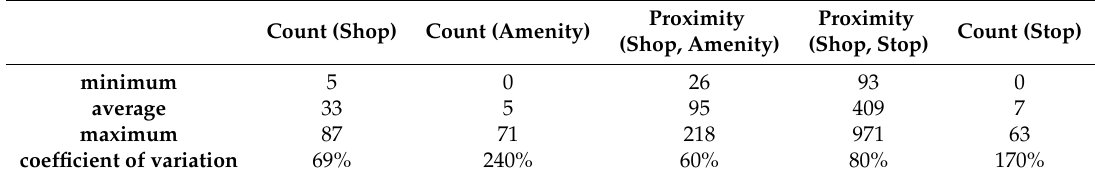
Table 5. Indicative results of spatial and statistical